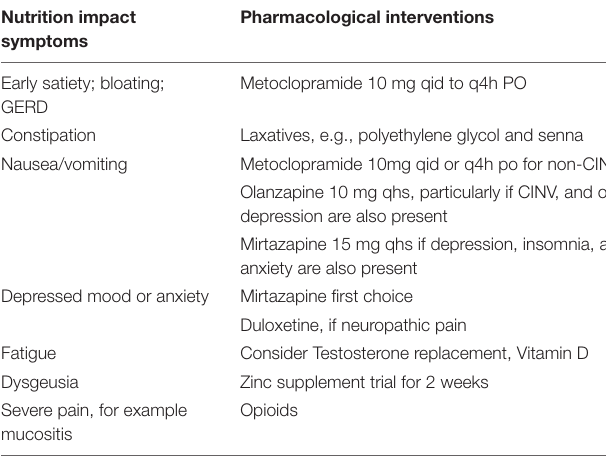
TABLE 1 | Pharmacologic management of